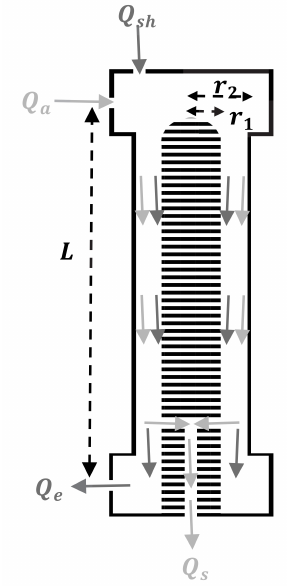
Figure 2. Simplified flow diagram of a DMA with an inner elec- trode radius r 1 , outer electrode radius r 2 , distance between aerosol inlet and sample outlet L , clean sheath air flow Q sh , aerosol flow Q a , excess air flow Q e , and sample air flow Q s